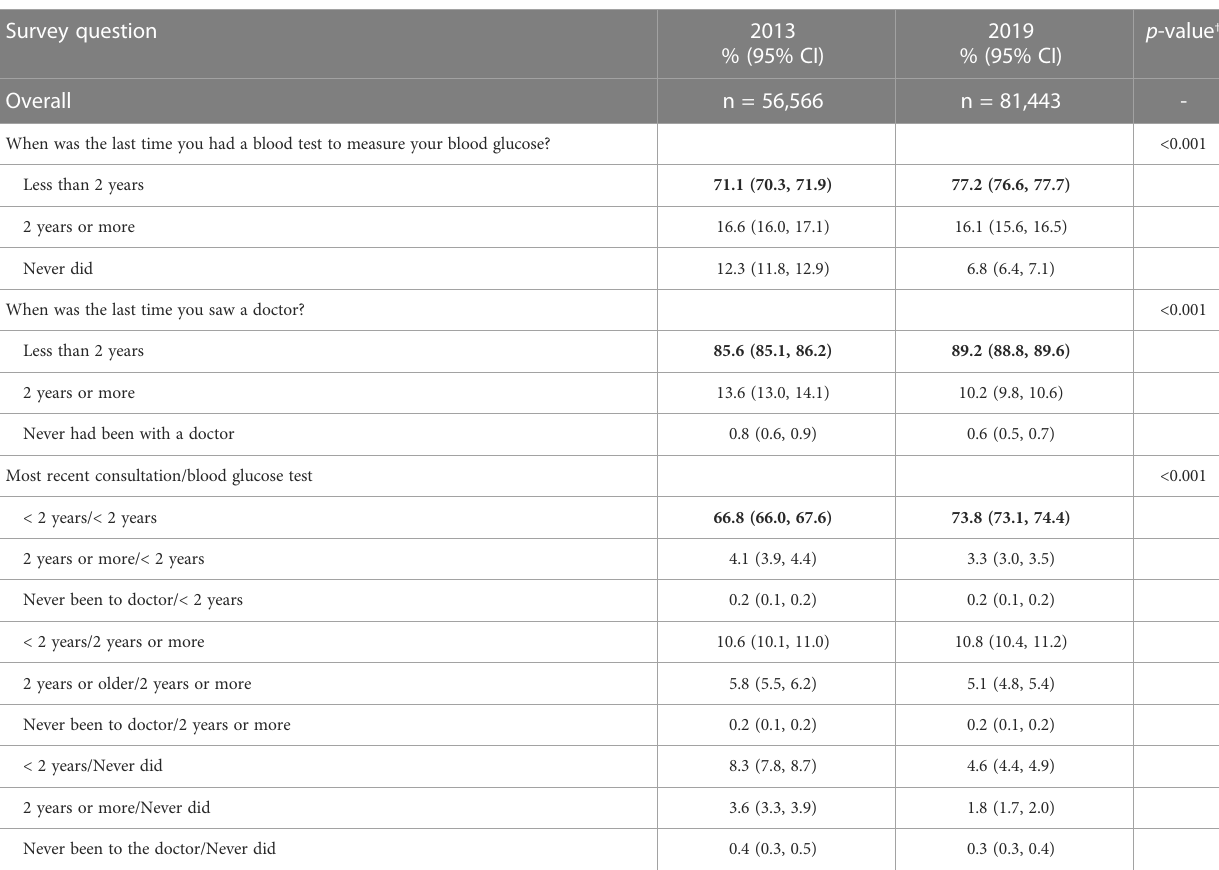
TABLE 2 Weighted percentage (95% CI) of adults without diabetes diagnosis, according to the time since the last medical consultation and last blood glucose test, in the Brazilian National Health Survey, 2013 and 2019 (n =